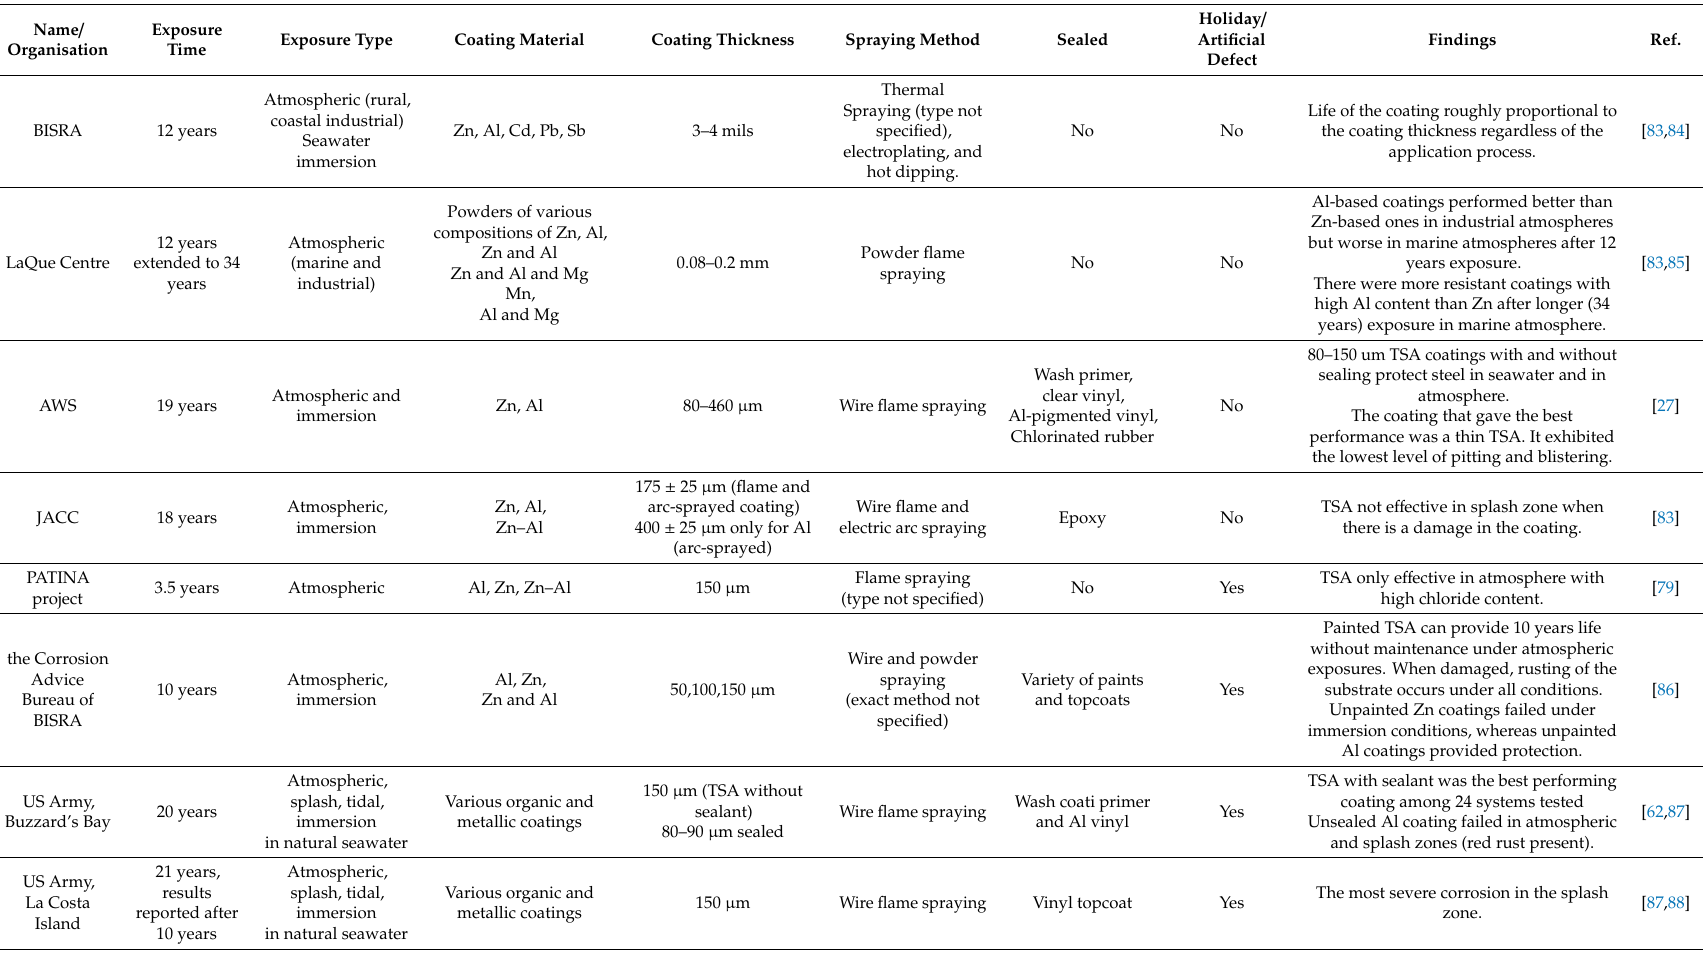
Table 4. Long-term field studies involving testing of thermally-sprayed aluminium (TSA)